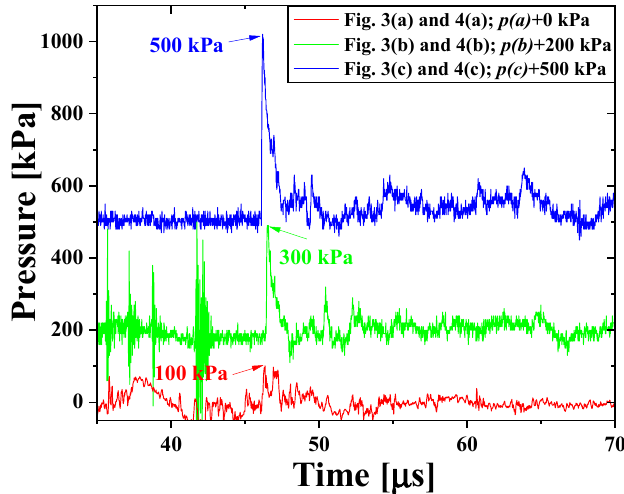
Figure 5. Pressure waveforms of a shockwave as a function of time.